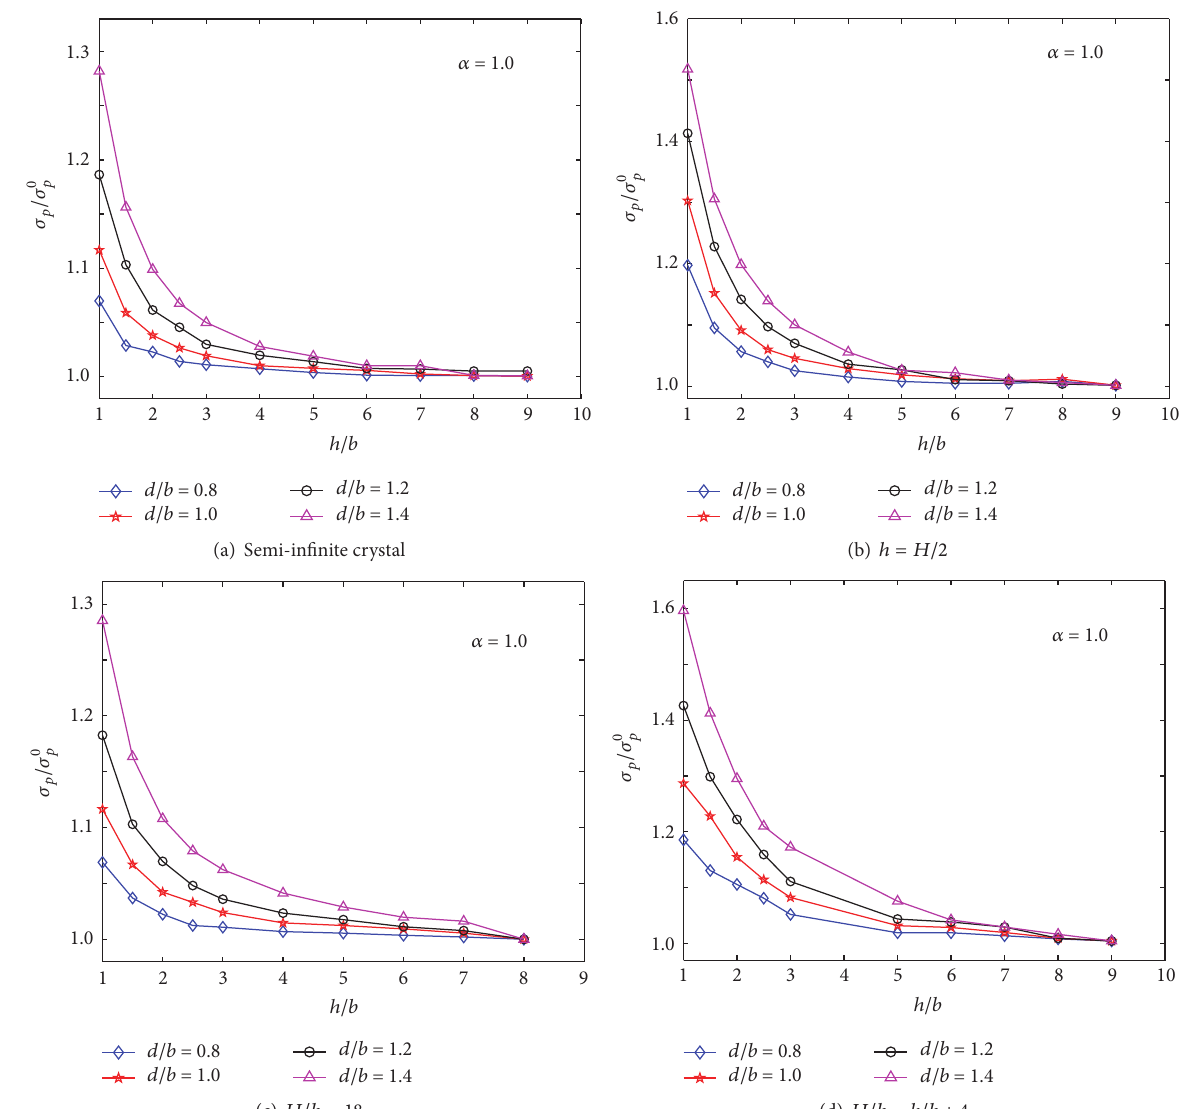
Figure 5: Variation of the amplification factors of Peierls stress for a screw dislocation with respect to its distance to the surface for various interplanar atomistic spacing ( 𝑑/𝑏